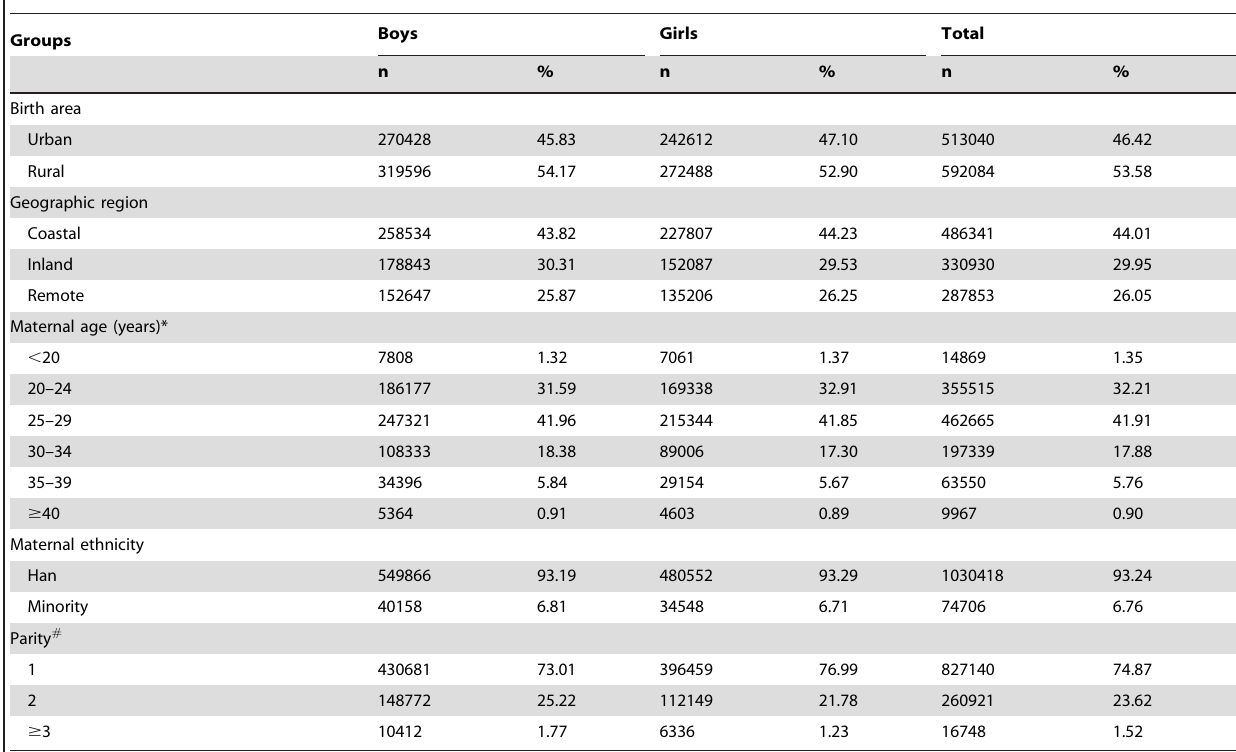
Table 1. Characteristics of the study